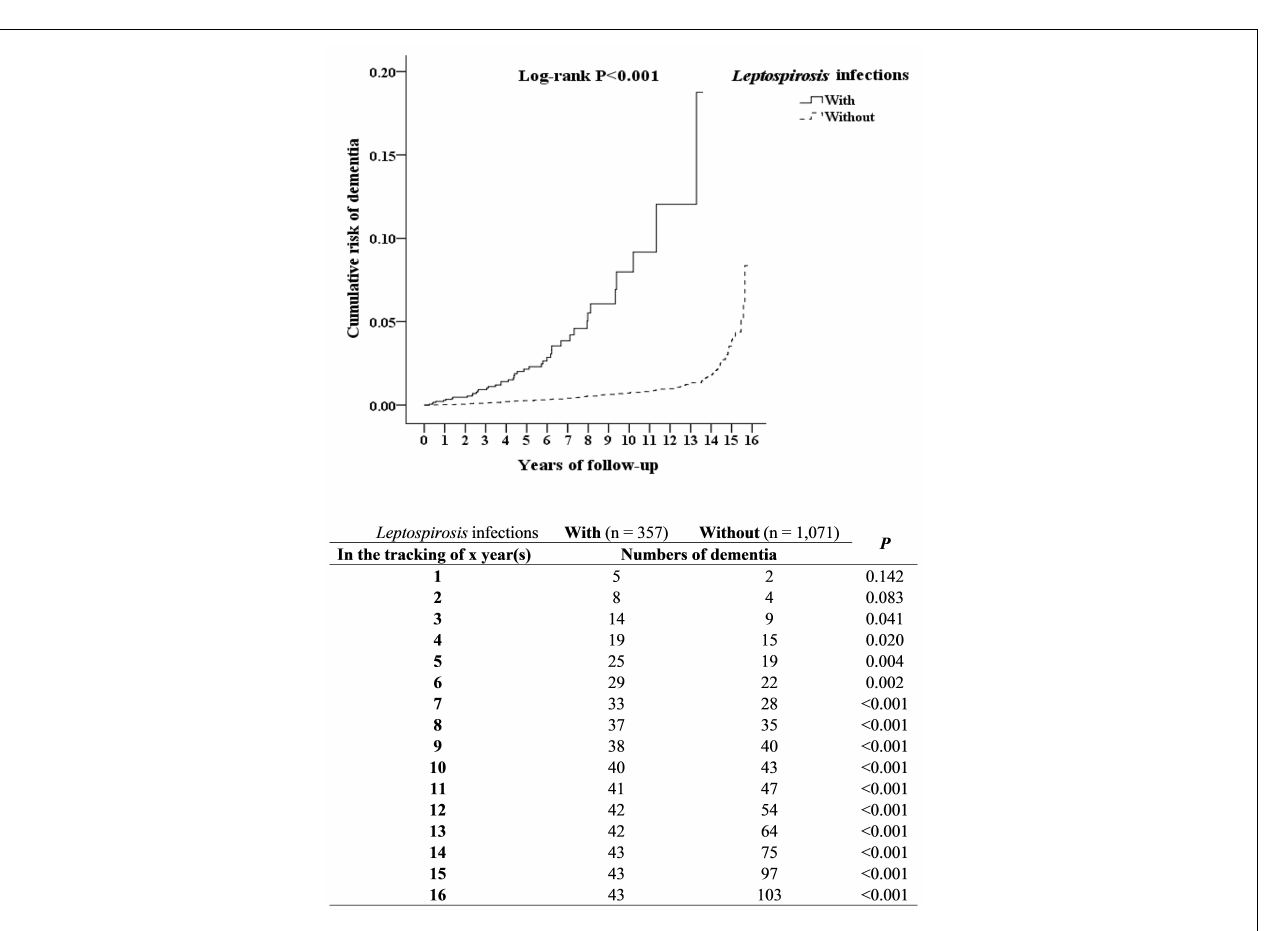
FIGURE 2 | Kaplan–Meier for cumulative incidence of dementia aged 50 and over stratified by Leptospirosis infections with log-rank test.